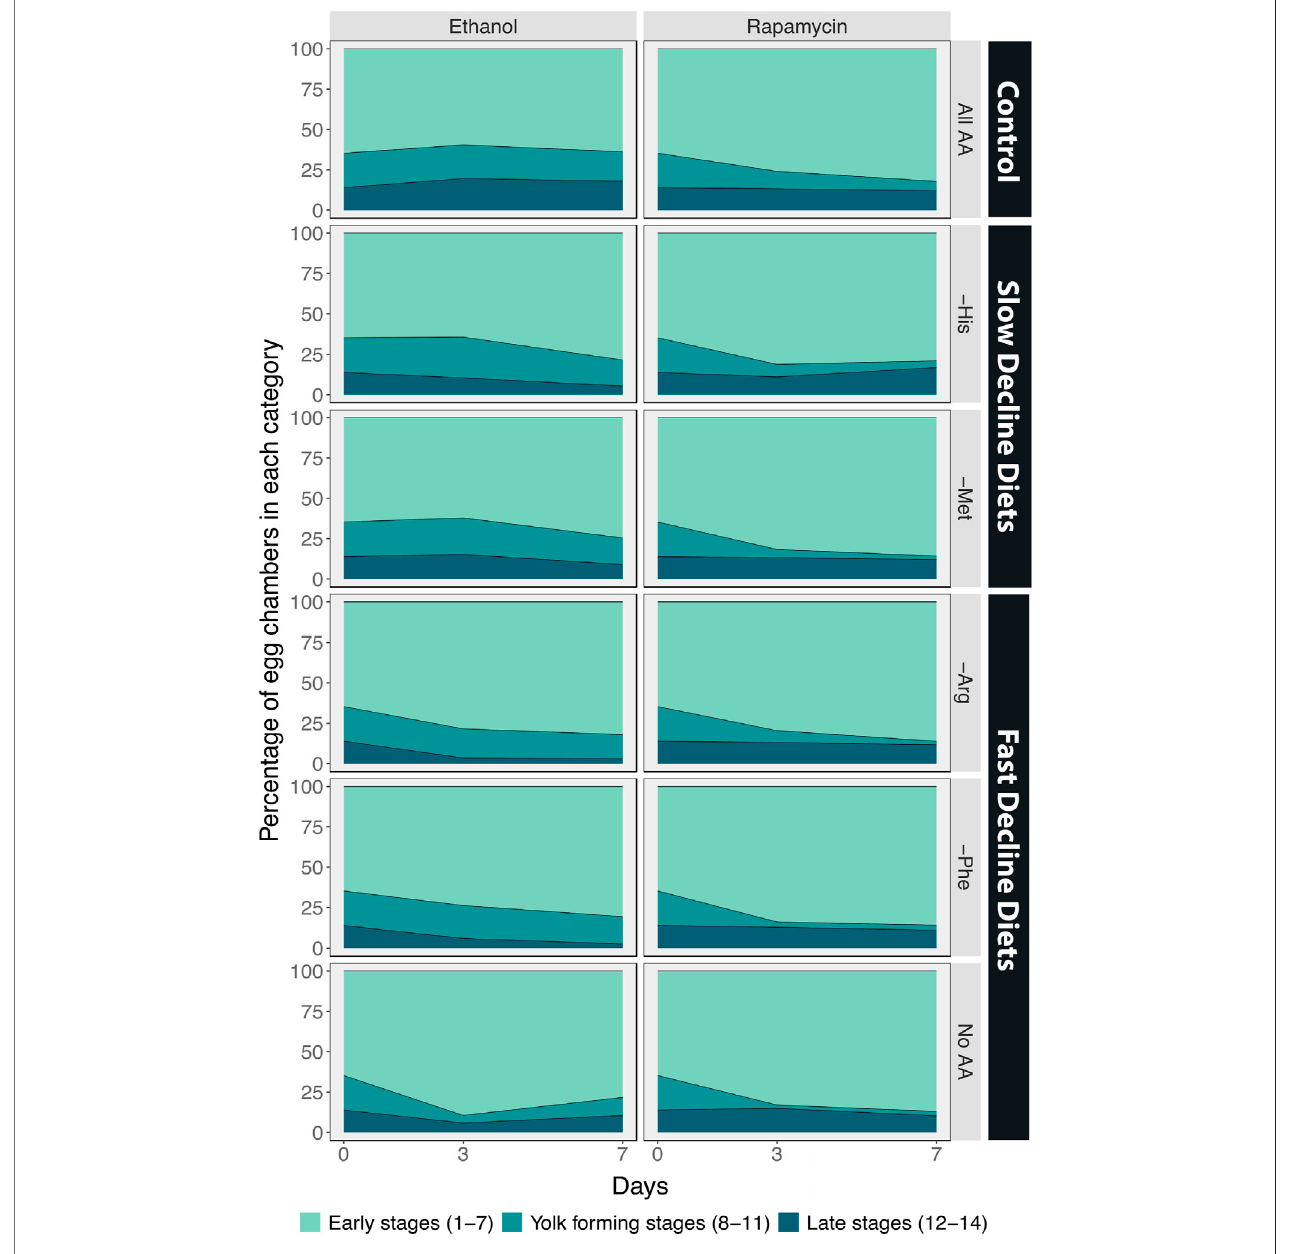
FIGURE 7 | The percentage of egg chambers in each category differs among amino acid drop-out diets, and these effects are eliminated when Target of Rapamycin signalling is inhibited using the drug rapamycin. Comparison between the percentage of egg chambers between red Dahomey females treated with ethanol and treated with rapamycin (30